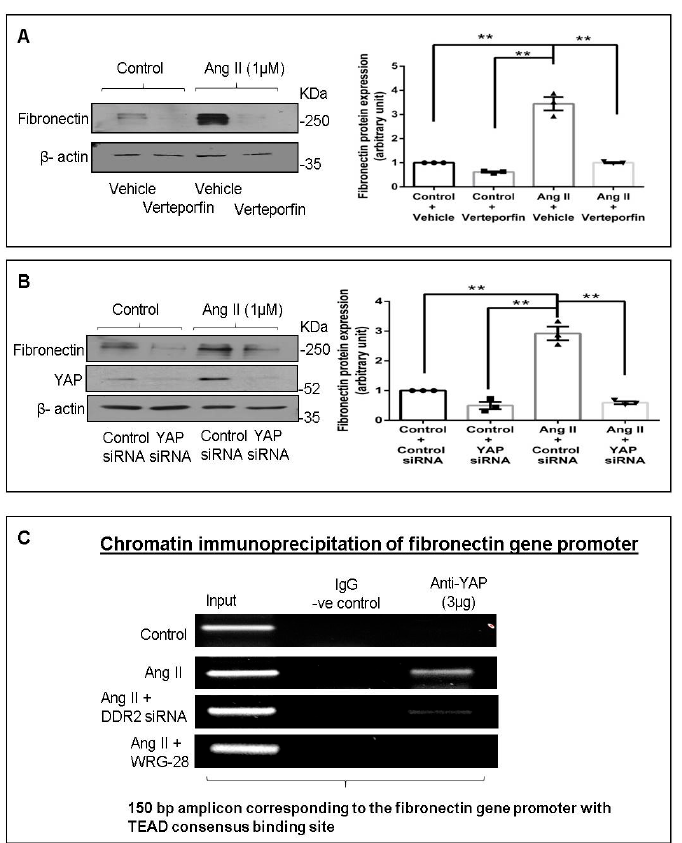
Figure 2. Transcriptional regulation of fibronectin by DDR2-activated YAP transcription co-activator. ( A ) Cardiac fibroblasts were treated with verteporfin (10 µM) for 1 h prior to Ang II treatment. Cells were collected at 12 h post-Ang II treatment, and fibronectin protein levels were examined, with β -actin as loading control. ** p < 0.01 (comparisons as depicted in the Figure). ( B ) Cardiac fibroblasts were transiently transfected with YAP siRNA (10 pmol) or control (scrambled) siRNA prior to treatment with Ang II for 12 h. Fibronectin protein expression was examined, with β -actin as loading control. Validation of DDR2 silencing is also shown. ** p < 0.01 (comparisons as depicted in the Figure). Data are representative of three independent experiments, n = 3, Mean ± SEM. ( C ) Sub-confluent quiescent cultures of cardiac fibroblasts were transiently transfected with YAP siRNA (10 pmol) or control (scrambled) siRNA prior to treatment with Ang II (1 µ M), and another set of cells was pre-treated with WRG-28 for 1 h. Cells were collected at 30 min post-Ang II treatment and chromatin was immunoprecipitated with anti-YAP antibody, followed by PCR amplification, and analyzed on a 2% agarose gel for presence of the 150 bp region of the fibronectin gene promoter containing the TEAD consensus binding